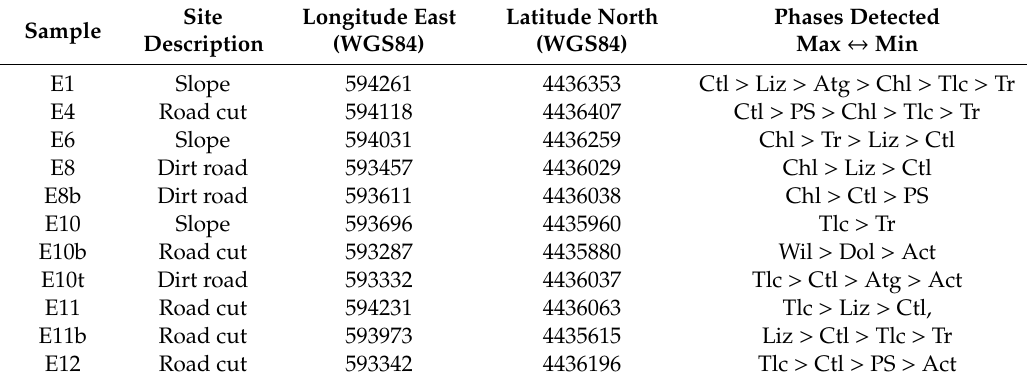
Table 1. Semi-quantitative mineralogical composition of samples in order of decreasing relative abundance, detected by X-ray powder diffraction (XRPD), scanning electron microscopy combined with energy dispersive spectrometry (SEM-EDS) and derivative thermogravimetry (DTG) analysis. Atg = antigorite, Lz = lizardite, Ctl = chrysotile, Act = asbestos actinolite, Tr = asbestos tremolite, PS = polygonal serpentine, Chl = chlorite, Will = willemseite, Dol = dolomite, and Tlc = talc. Mineral symbols after [38].